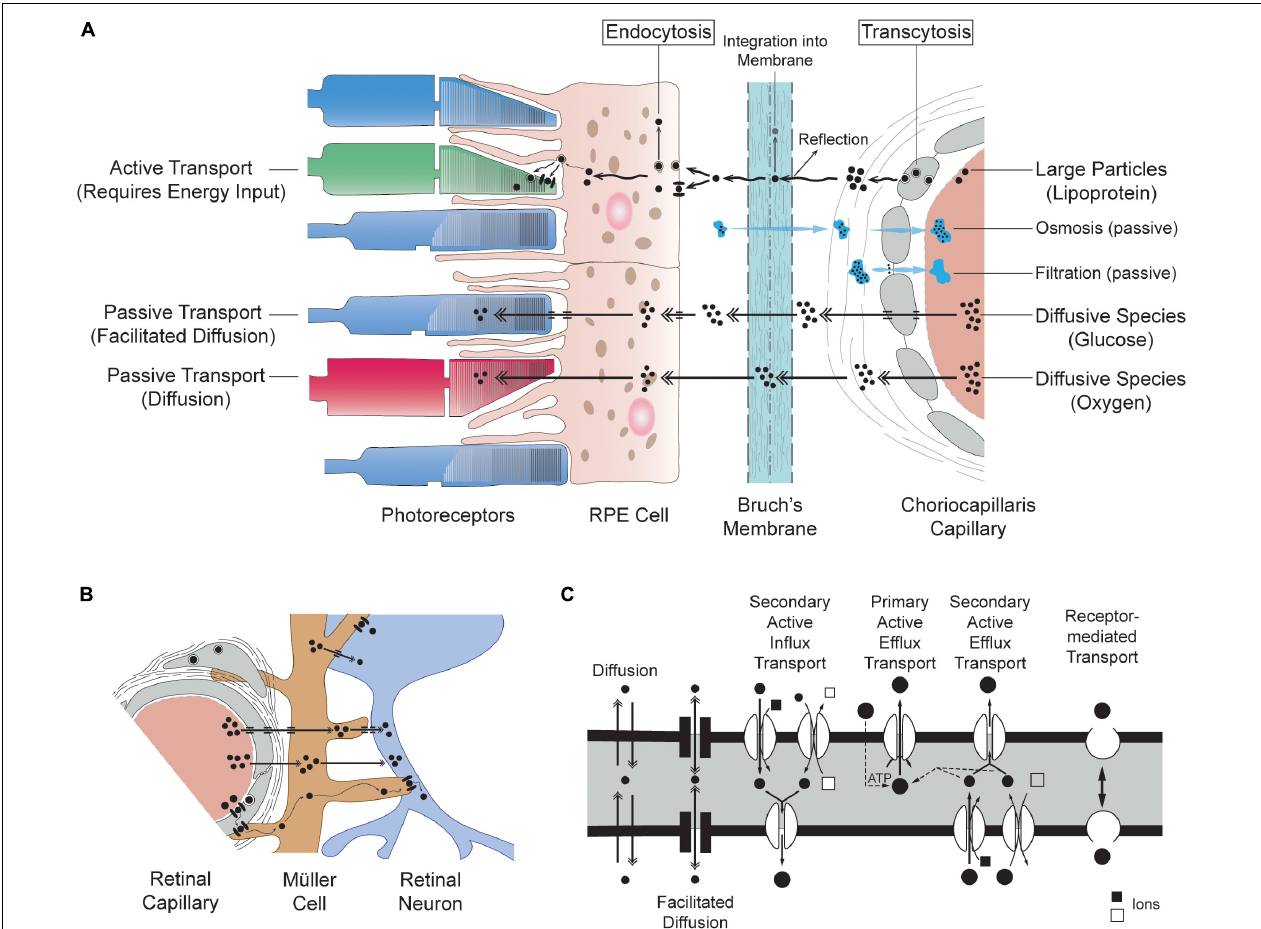
FIGURE 3 | Schematic representation of mass transport systems of the retina. The movement of molecules shown in (A,B) is directed from vasculatures to tissue only for simplicity; although, displayed mechanisms are also applicable to the opposite direction. (A) Simplified schematic of the transfer of material across choriocapillaris endothelial cells, Bruch’s membrane, RPE cells and photoreceptors (not to scale). (B) Mass transfers in the inner retina illustrating the symbiotic relationship between retinal endothelial cells, glial cells (here a Müller cell) and retinal neurons. (C) Schematic of the mechanisms of transport across cells adapted and modified from Hosoya and Tachikawa (2012). Transport is traditionally classified as passive (diffusion), carrier-mediated (facilitated diffusion, primary active efflux and secondary active influx and efflux) or receptor-mediated. The conventions used to depict mechanisms of transport in (A,B) are consistent with (C) .